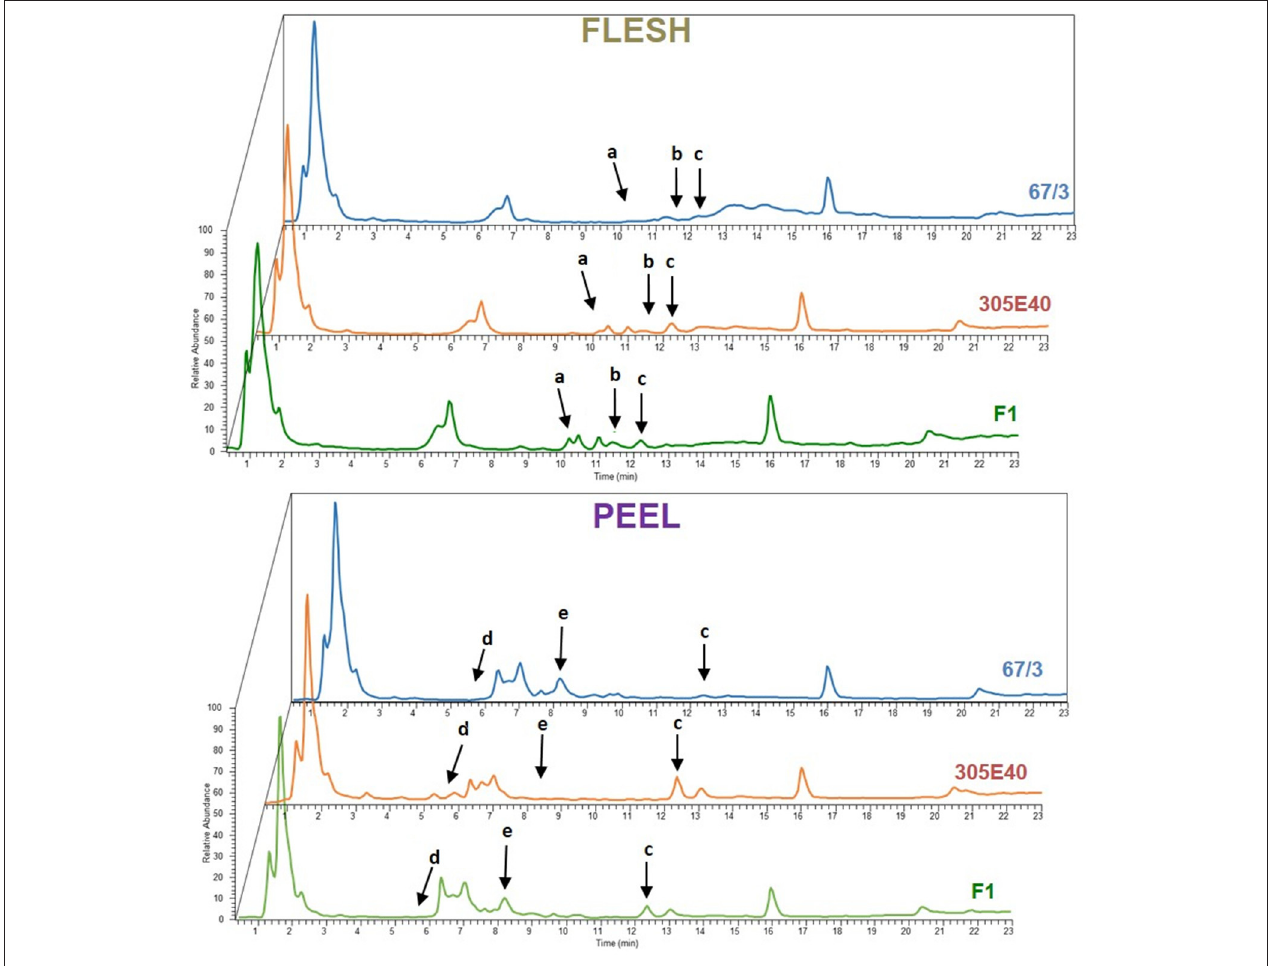
FIGURE 2 | Representative Total Ion Current (TIC) chromatograms of flesh and peel samples from parental lines “67/3” (blue), “305E40” (orange), and F1 hybrid (green). Arrows indicate differentially expressed peaks: a, solamargine; b, malonylsolamargine; c, pseudoprotodioscin; d, delphinidin-3-rutinoside; e,